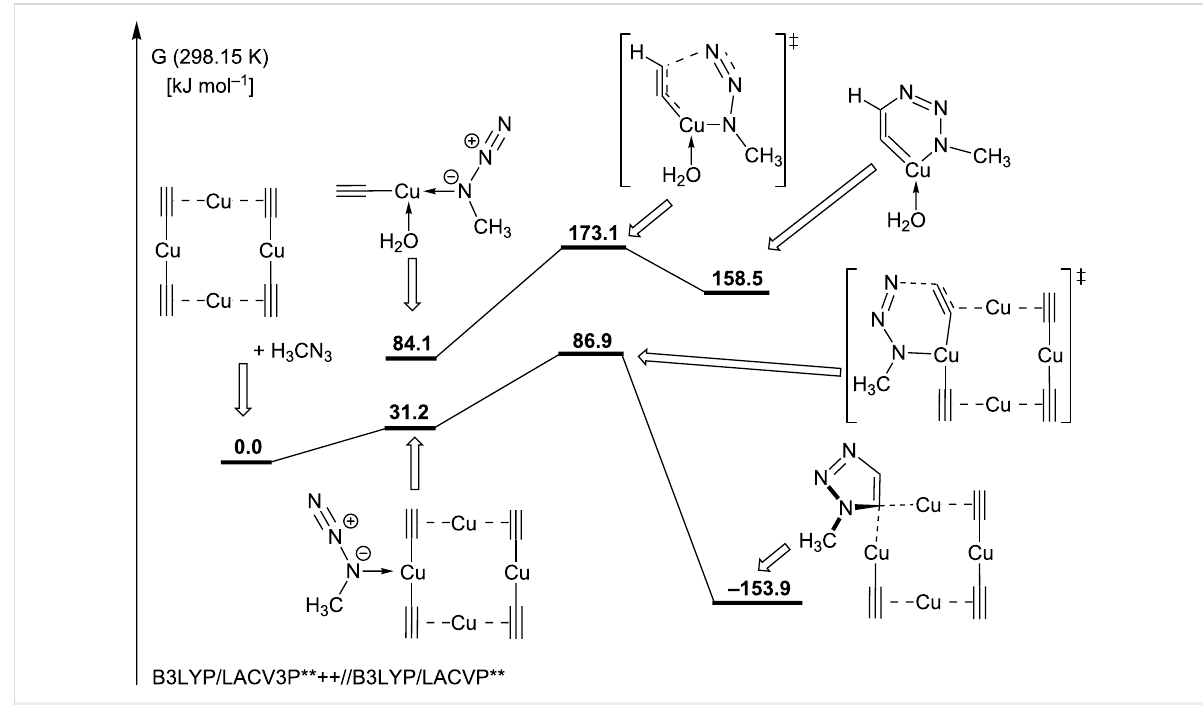
Figure 8: Gibbs free energy diagram for the computed mechanistic pathway of the CuAAC reaction starting from a tetranuclear copper(I) μ -acetylide model complex [186].